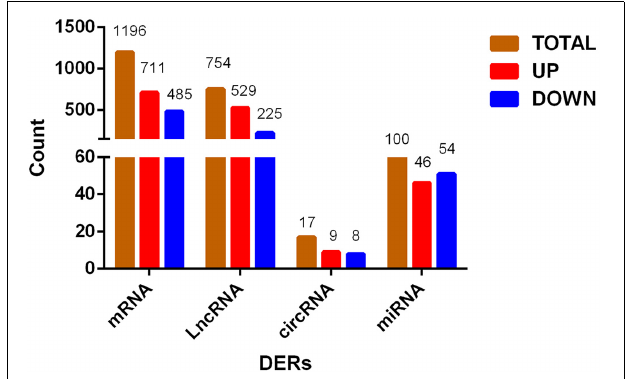
FIGURE 2 | Histogram of differentially expressed RNA shared by three groups. From preadipocytes to mature adipocytes, brown column is the number of total differentially expressed RNAs, red column is RNAs with increased expression, and blue column is RNAs with decreased